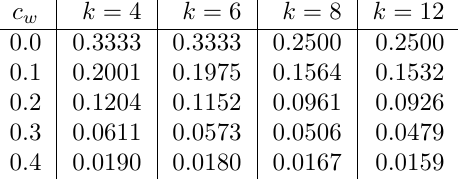
for k = 4 , 6 , 8 and n